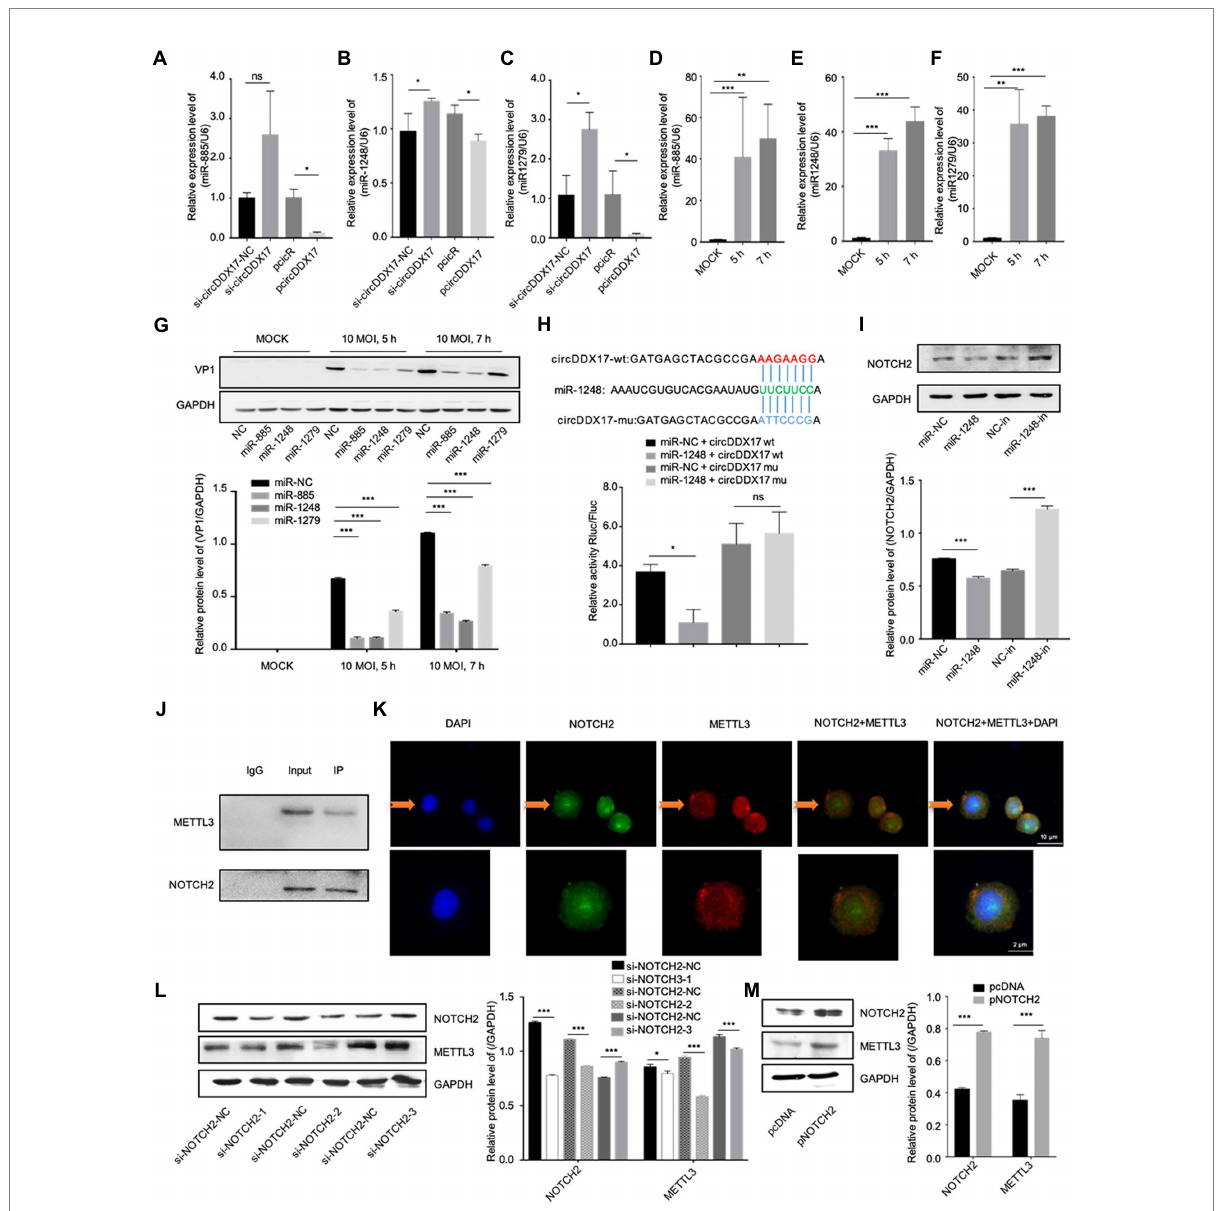
FIGURE 3 CircDDX17 promotes CVB3 replication by targeting miR-1248, and miR-1248 targeting NOTCH2. (A–C) Relative expression levels of miR-885, miR-1248, and miR-1279 in HeLa cells were determined by RT-qPCR after cells overexpression or silence the circDDX17. (D–F) RT-qPCR to detected expression of miR-885, miR-1248, and miR-1279 in CVB3 (10 MOI) infected HeLa cells. (G) HeLa cells transfected with miR-885, miR- 1248, and miR-1279, infected the CVB3 (10 MOI) for 7 h. Western blot analysis of the VP1 expression. (H) The putative miR-1248 binding site in circDDX17 (circDDX17-wt) and the designated mutant sequence (circDDX17-mu) are illustrated. Validation of circDDX17 targeting on miR-1248 luciferase assay. (I) HeLa cells transfected miR-1248 mimics or miR-1248-in, indicated NOTCH2 detected by Western blot. (J) Immunoprecipitation and immunoblot analyses were performed with the indicated antibodies. (K) HeLa cells stained with anti-NOTCH2 (green) and anti-METTL3 (red) antibody and were analyzed by confocal microscope. Nuclei were labeled with DAPI (blue). Micrographs with × 40 magnification (scale bar of 10 μ m) are shown. (L) HeLa cells transfected si-NOTCH2, indicated signals were detected by Western blot. (M) NOTCH2 overexpression in HeLa cells. Indicated signals were detected by Western blot. * p < 0.05, ** p < 0.01, *** p <